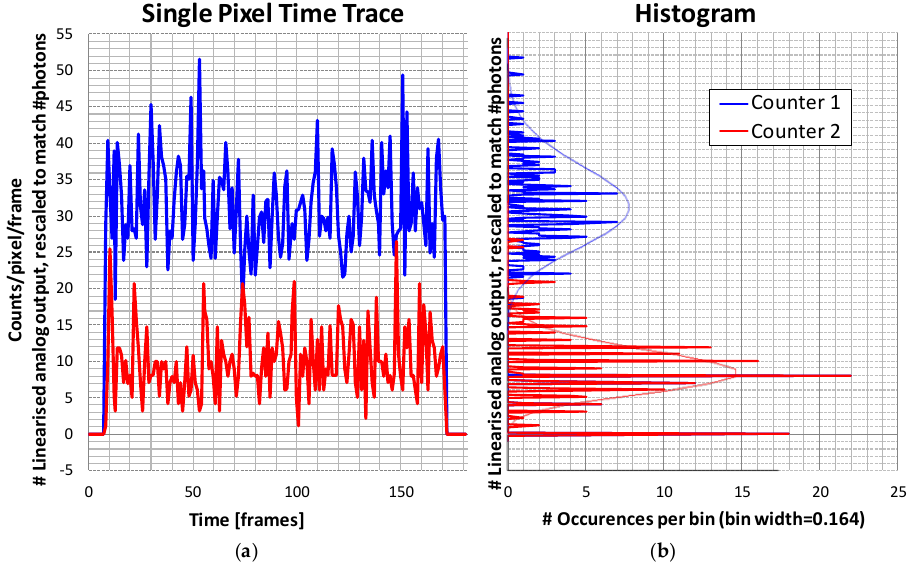
Figure 12. One pixel, two thresholds, observed over a time comprising 180 frames. Beam powers on at frame 9 and powers off after frame 170. ( a ) Counts versus frame number; ( b ) Horizontal histogram of the occurrences of analog count values. Thin red and blue lines are theoretical Poisson distributions with the same average counts.